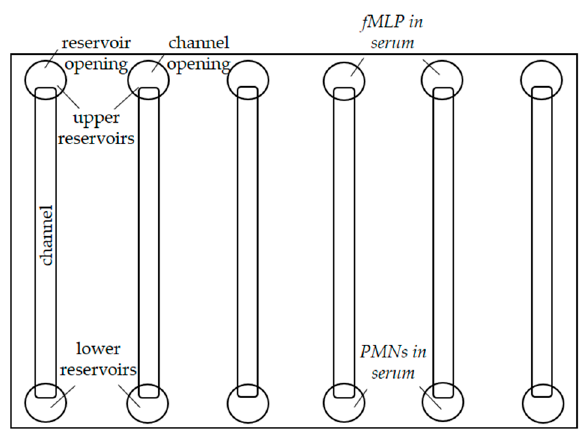
Figure 7. Schematic representation of the µ-Slides VI 0.1 used.